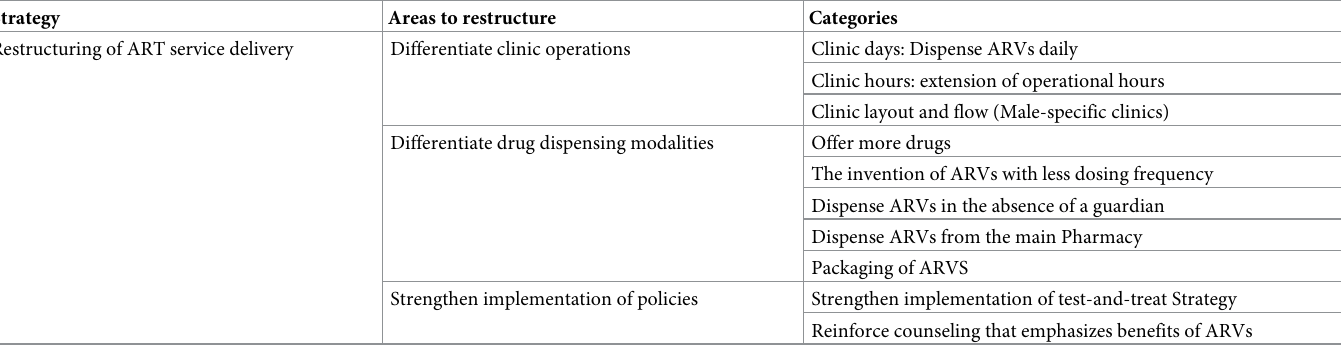
Table 2. Summary of key findings.